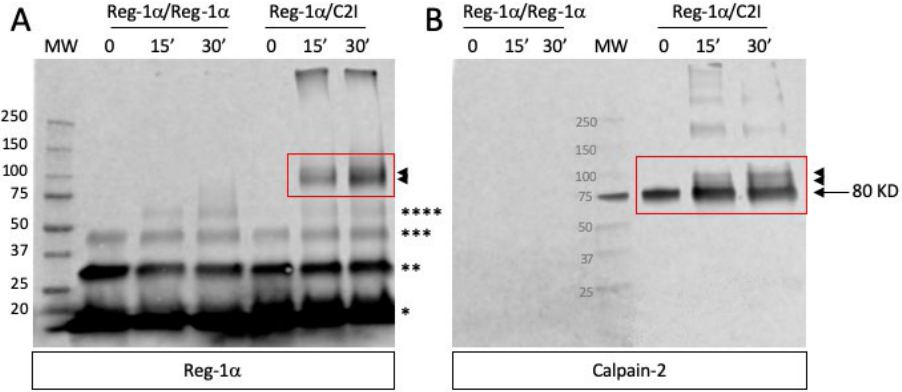
Figure 2. Interaction of Reg-1 α with calpain-2. The cross-linking reactions (after 0, 15, and 30 min), namely Reg-1 α + calpain-2 in its inactive form (Reg-1 α /C2I) (red frame) and Reg-1 α alone (Reg-1 α /Reg-1 α ) were carried out as described in Section 4. SDS-PAGE was performed on a 4-15% acrylamide gel, and the presence of cross-linked products was evidenced after transfer of the proteins on a PVDF membrane by double immunodetection with anti-Reg-1 α ( A ) and anti-calpain-2 ( B ) antibodies. The covalent products are indicated by arrowheads. Note the presence of Reg1 α monomers (*), dimers (**), trimers (***) initially present and tetramers (****) visible only after the crosslinking reaction of Reg-1 α alone.